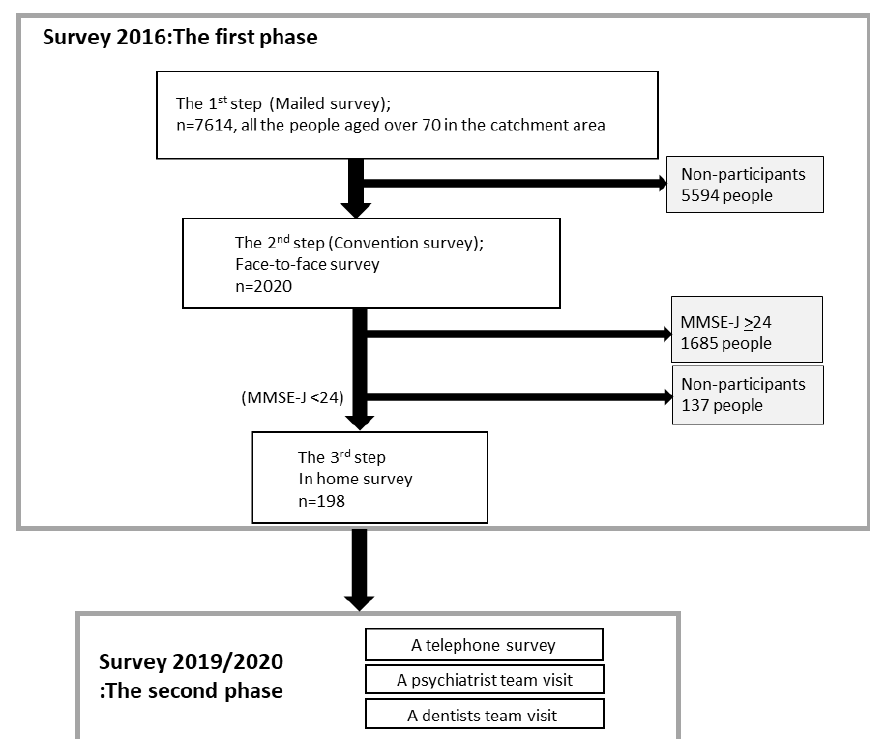
Figure 1. Study flow. The Takashimadaira Study included a 2016 epidemiological study (the first phase) to study the prevalence of dementia and a 2019 prognostic study (the second phase) among those at high risk of cognitive decline and social isolation.